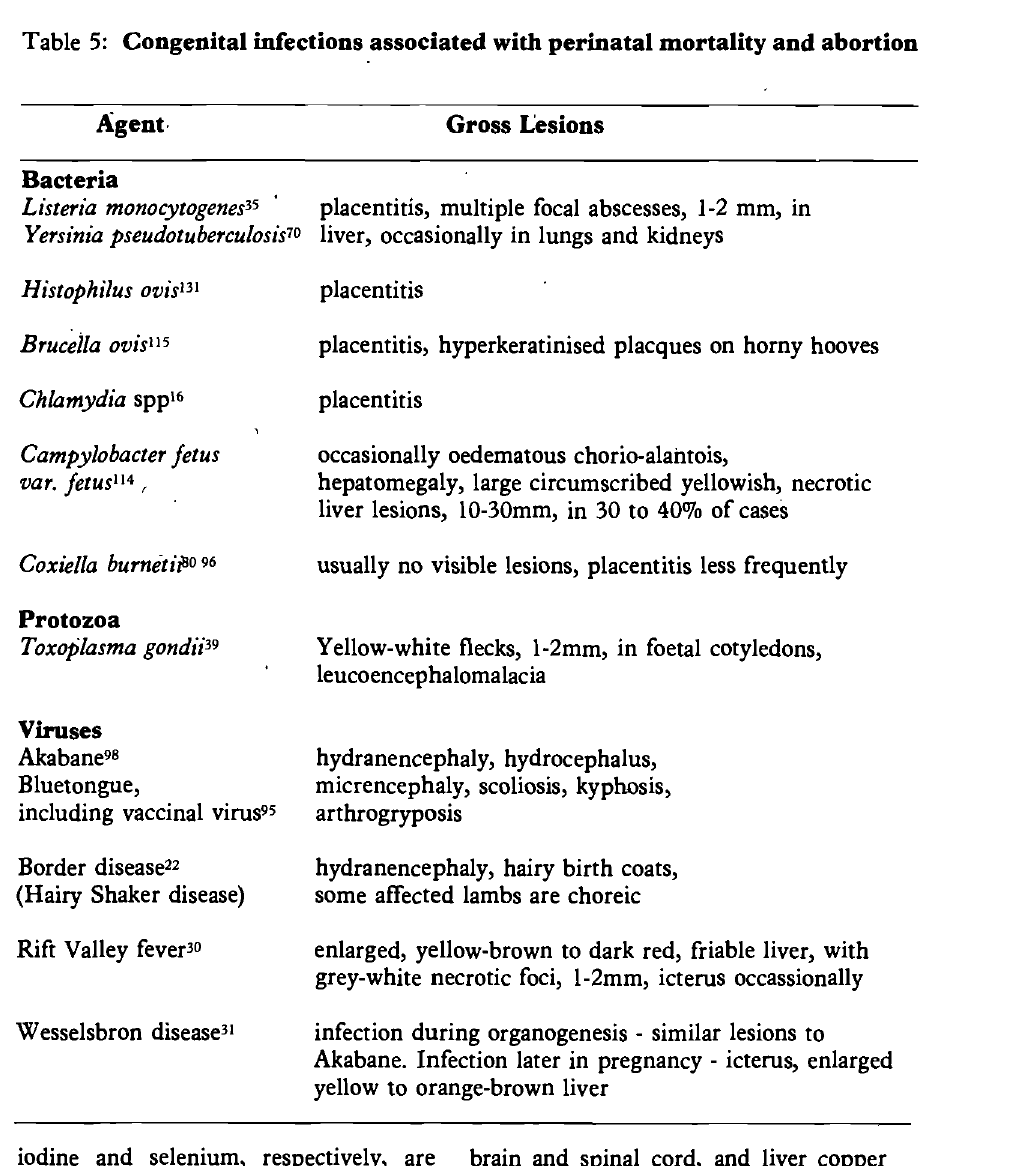
Table 5: Congenital infections associated with perinatal mortality and abortion